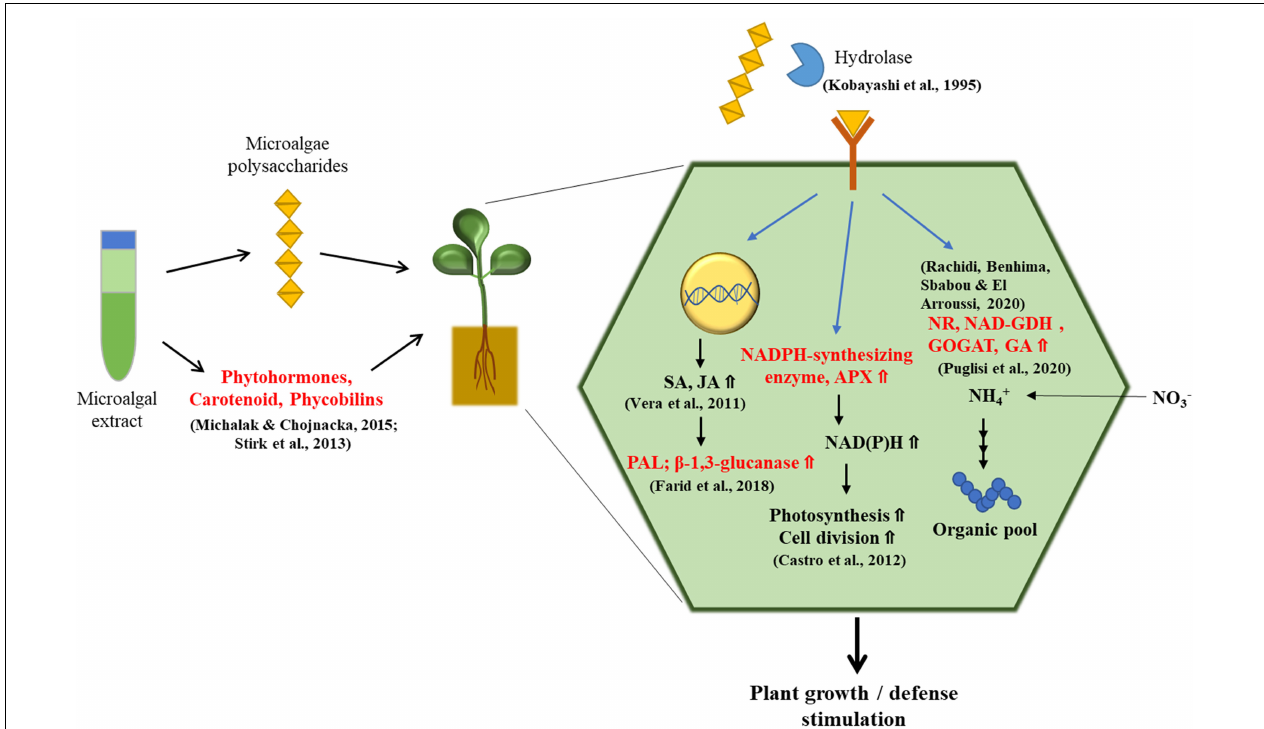
FIGURE 1 | The treatment of microalgae extracts stimulates plant growth and defense system. Microalgal extracts contain many plant growth-promoting compounds such as polysaccharides, phytohormones, carotenoids, and phycobilins, which have the ability to stimulate the plant growth and defense system. Large polysaccharides from microalgal extracts are broken down into smaller fragments of oligosaccharides by hydrolytic enzymes. Oligosaccharides are perceived by plant’s membrane receptor and have a significant stimulatory effect on the plant growth by regulating activities of enzymes such as nitrate reductase (NR) and NAD-glutamate dehydrogenase (NAD-GDH) related with nitrate assimilation. Moreover, polysaccharides can increase activity of NADPH-synthesizing enzymes, ascorbate peroxidase (APX), and the amount of ascorbate (AsA), which are associated with photosynthesis, fundamental cellular metabolism, and cell cycle. Defense pathways are also stimulated by polysaccharides in plant cells: polysaccharide treatment upregulates the expression of genes involved in salicylic acid (SA) and jasmonic acid (JA) signaling pathways, resulting in increased activities of β -1,3-glucanase and phenylalanine ammonia lyase (PAL) linked to plant defense system.